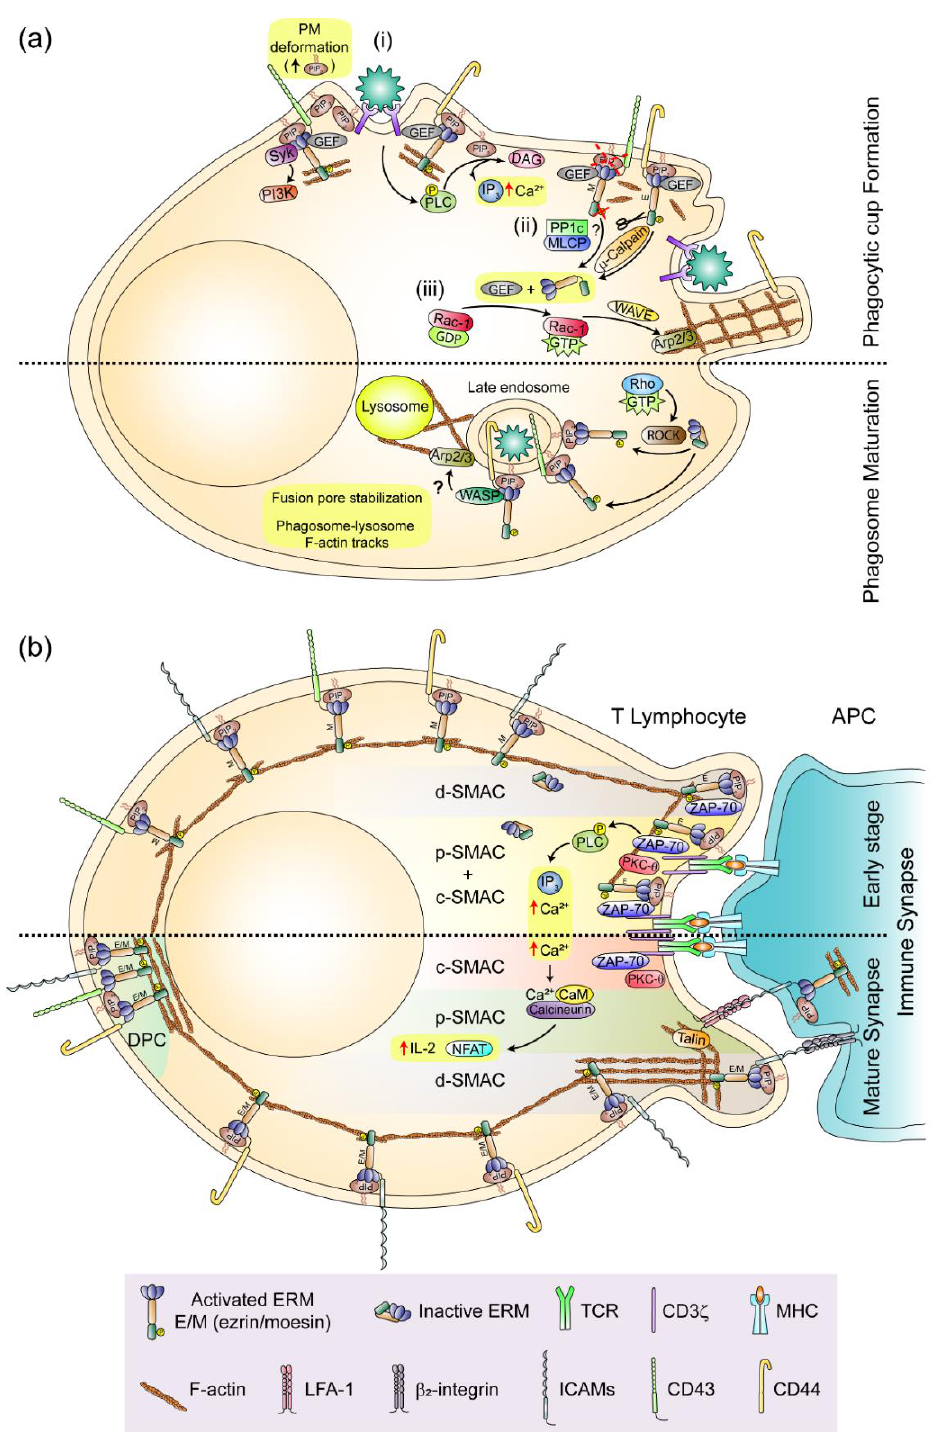
Figure 3. Organization of leukocyte interactions by ERMs. ( a ) The phagocytic cup and the phagosome. Upper part, three-step phagocytic cup formation in direct receptor-mediated phagocytosis (e.g., scavenger and apoptotic cell recognition receptors): (i) receptor-mediated cell binding and recruitment of PIP 2 and ERMs to deformed PM. PLC and Syk signaling from the phagocytic receptor and the ERM-bearing immunoreceptor tyrosine-based activation motif (ITAM) are respectively depicted; (ii) activation of PLC from the phagocytic receptor reduces PM PIP 2 and increases intracellular Ca 2+ levels, which may release ERMs from the PM and activate Rac-1 through the specific cleavage of ezrin by calpain and dephosphorylation of ERMs by myosin light chain phosphatase (MLCP); (iii) activation of Rac-1 by GEFs released from inactivated/closed ERMs may stimulate actin polymerization by the WAVE-Arp2/3 complex, giving rise to the phagocytic cup. Lower part,